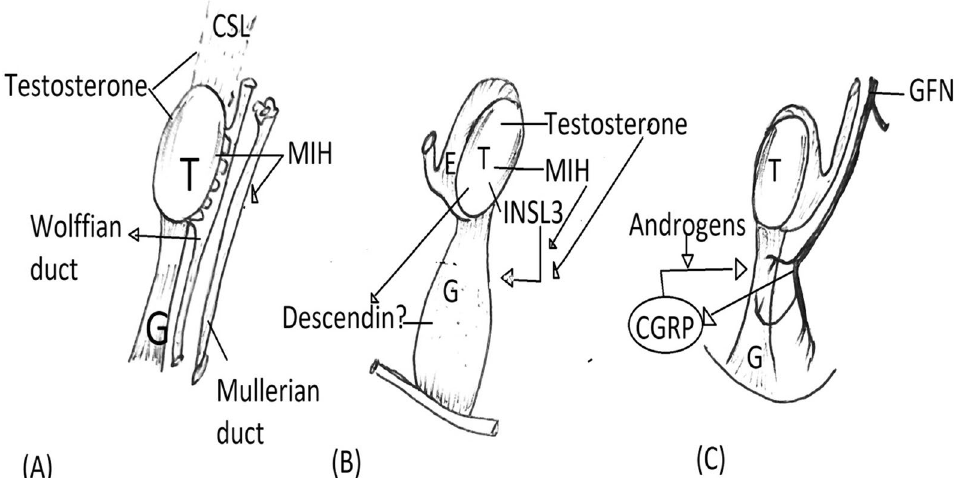
Fig. 2 Diagrammatic schema showing the hormonal factors influencing the testicular descent. A Shows early gonadal position in gonadal ridge. In the male foetus, MIH and testosterone causes the regression of the embryonic müllerian duct and regression of CSL, respectively. B MIH or Testosterone amplifies the action of INSL3 which stimulates gubernaculum enlargement. Descending is proposed to cause selective growth of gubernacular mesenchymal cells which might aid in testicular descent. C Androgens via CGRP released by the GFN influences the gubernacular migration and elongation in the inguinoscrotal